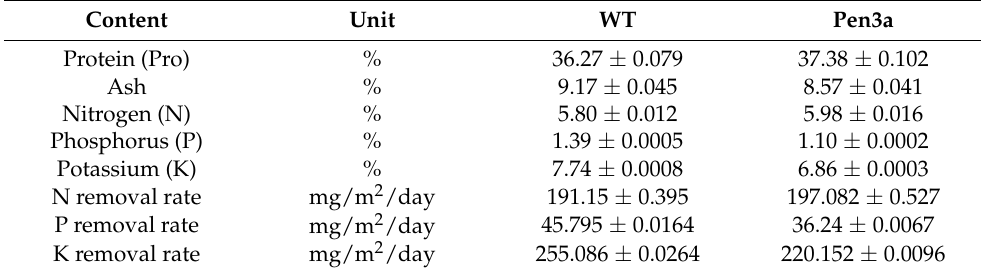
Table 1. Production of duckweeds (dry wight).